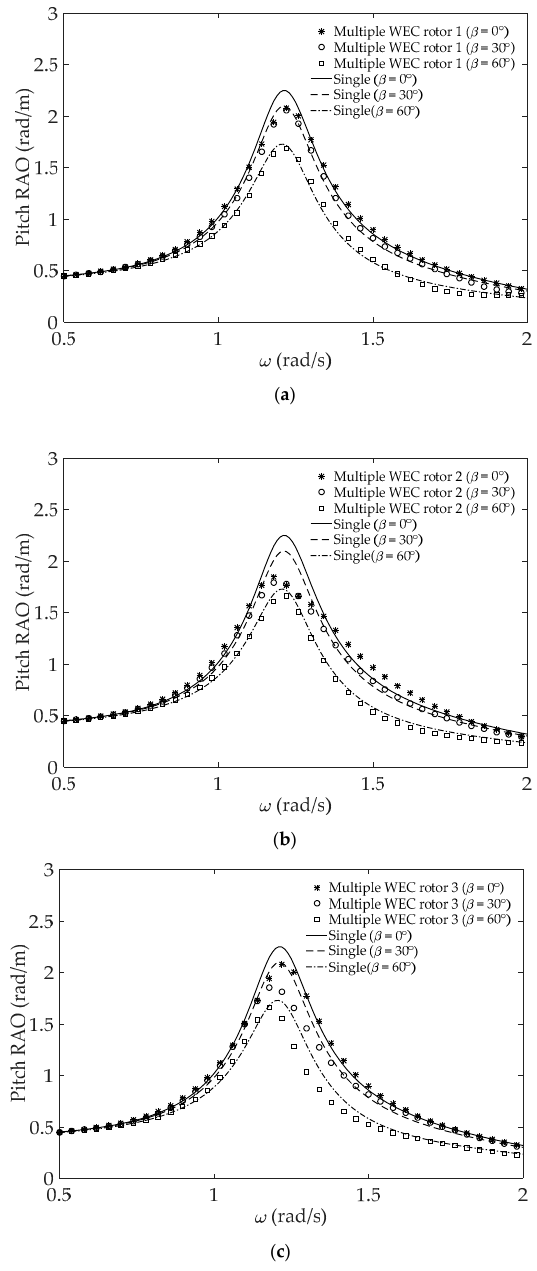
Figure 7. Pitch RAO (rad/m) of isolated and multiple WEC rotors without PTO as a function of the wave frequency (rad/s). Comparison of isolated WEC rotor and multiple WEC rotors ( a ) 1, ( b ) 2, and ( c ) 3.